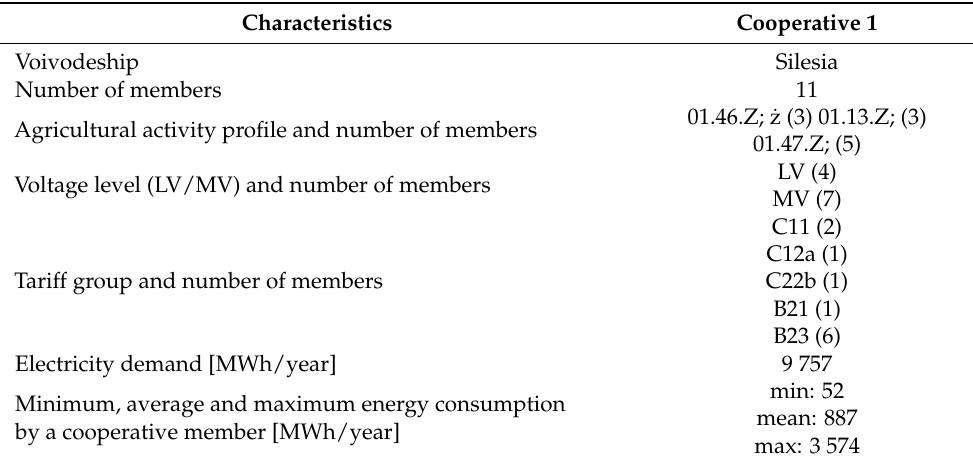
Table 1. Characteristics of the selection of farms.